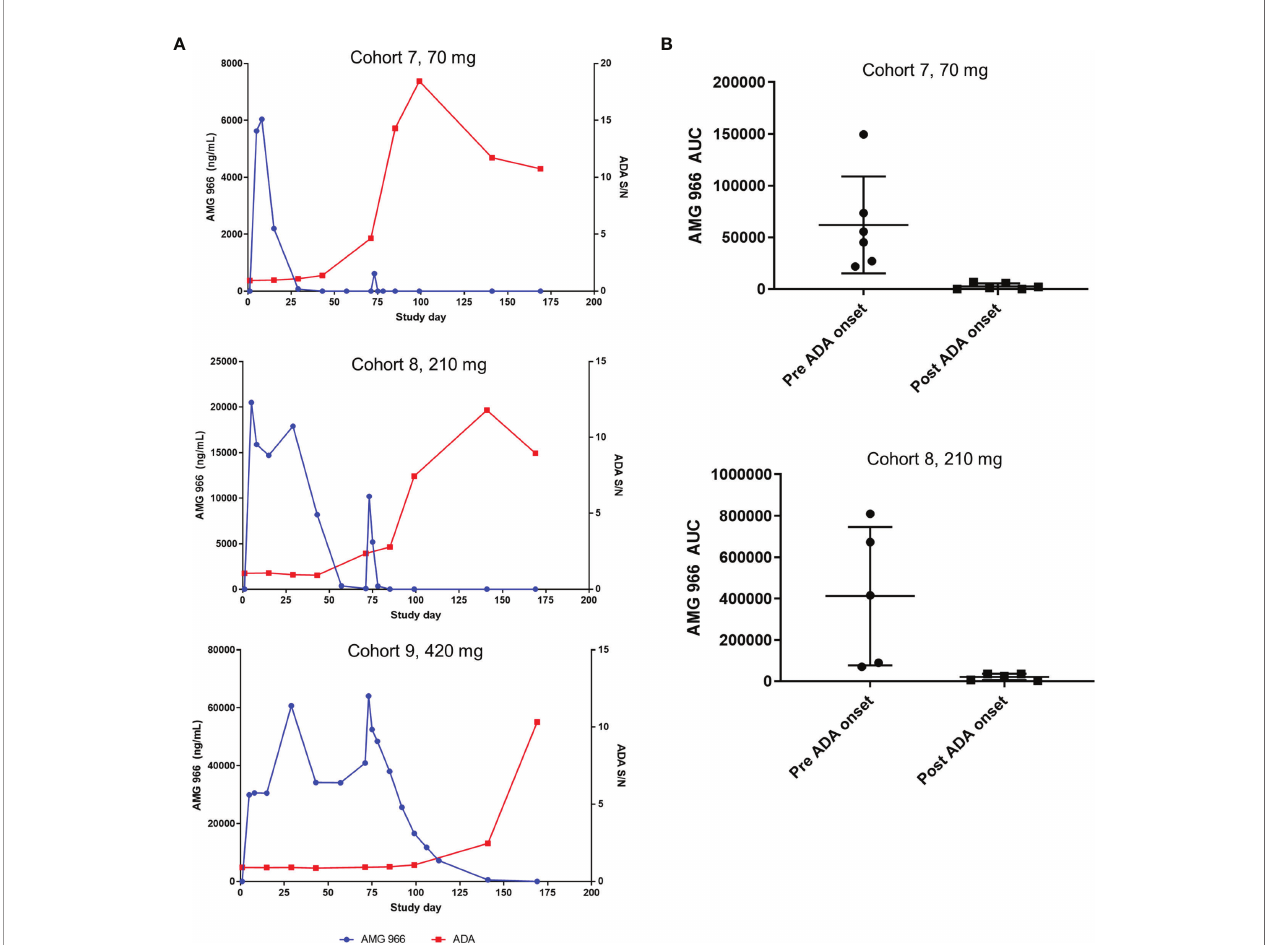
FIGURE 3 | Anti-AMG 966 antibodies impacted exposure in MAD cohorts. (A) AMG 966 concentration is plotted together with the magnitude of the anti-AMG 966 antibody response, shown as signal to noise ratio. Representative subjects are shown from each MAD cohort. Subjects were dosed Q2W with the last dose administered on day 71. (B) AMG 966 area under the curve (AUC) is shown pre and post ADA onset in cohorts 7 and 8. ADA onset was de fi ned as the fi rst study timepoint with an ADA positive result. For cohort 9, all subjects maintained exposure throughout the dosing phase, and ADA onset was too late to assess impact on